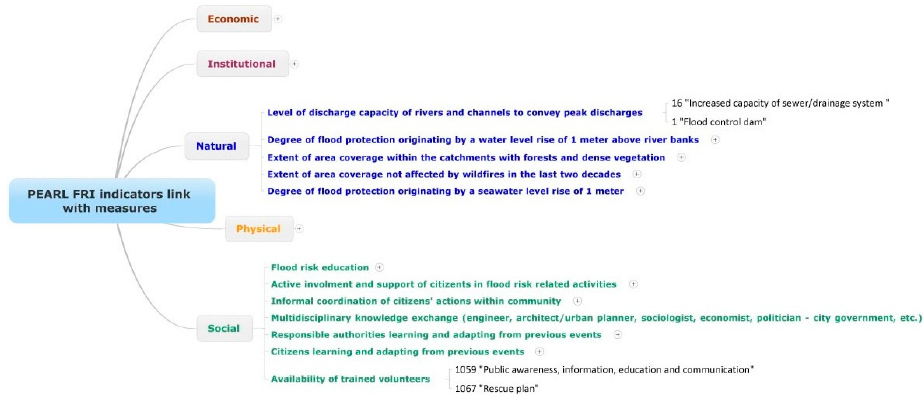
Figure 10. Mind map linking indicators per dimension with resilience measures.